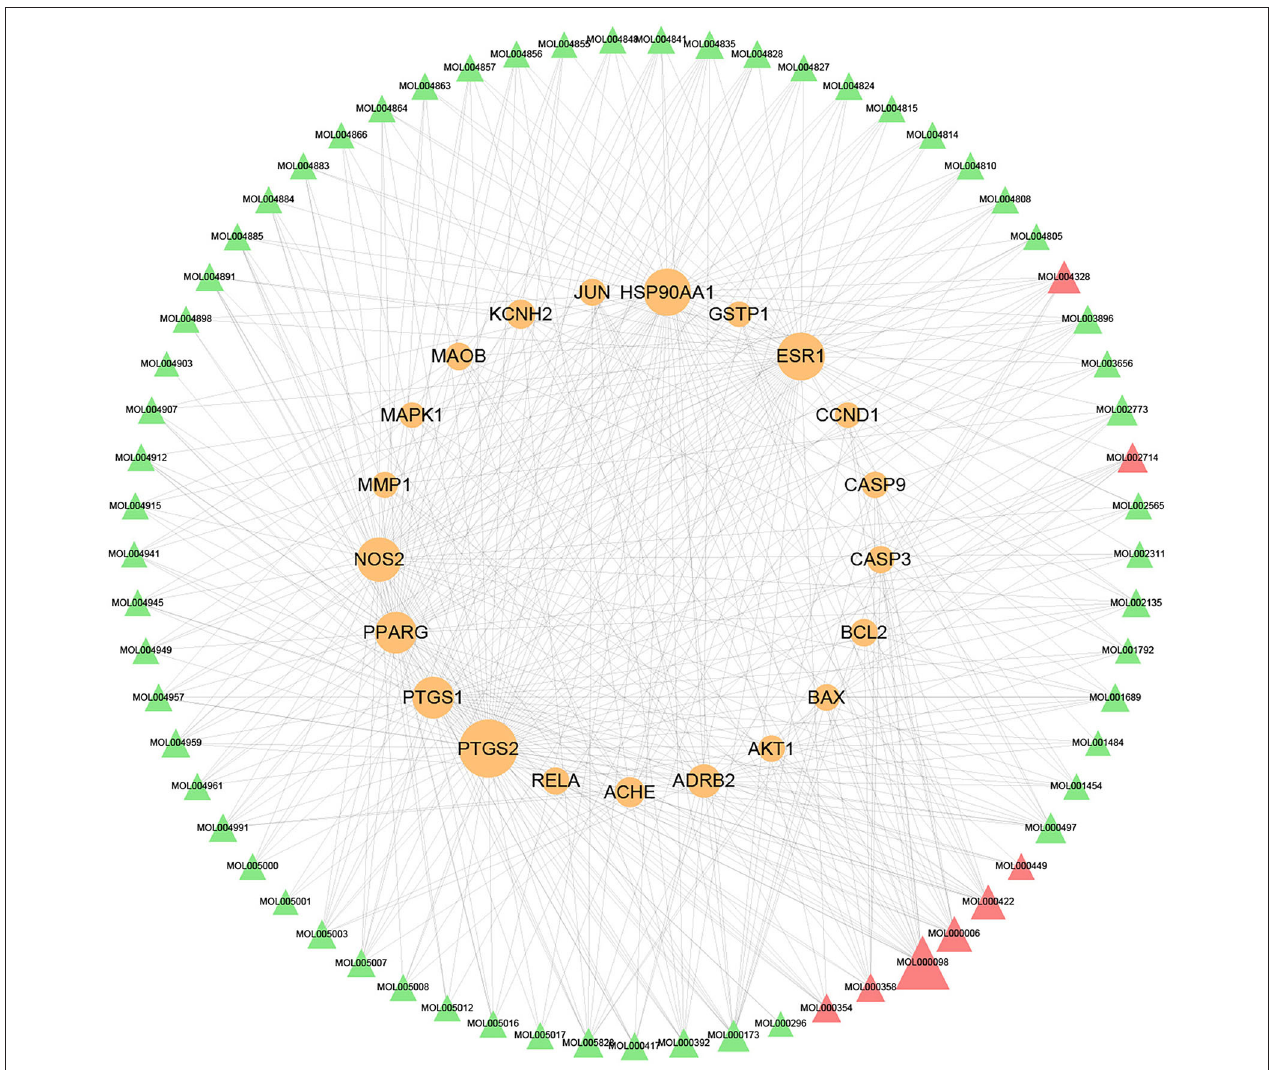
FIGURE 3 | Topological compounds–targets network of Xuefu Zhuyu decoration (XFZYD). Orange ellipse nodes represent potential therapeutic targets, and green and red triangle nodes represent effective compounds. The size of node is proportional to the value of the degree centrality by topology analysis.